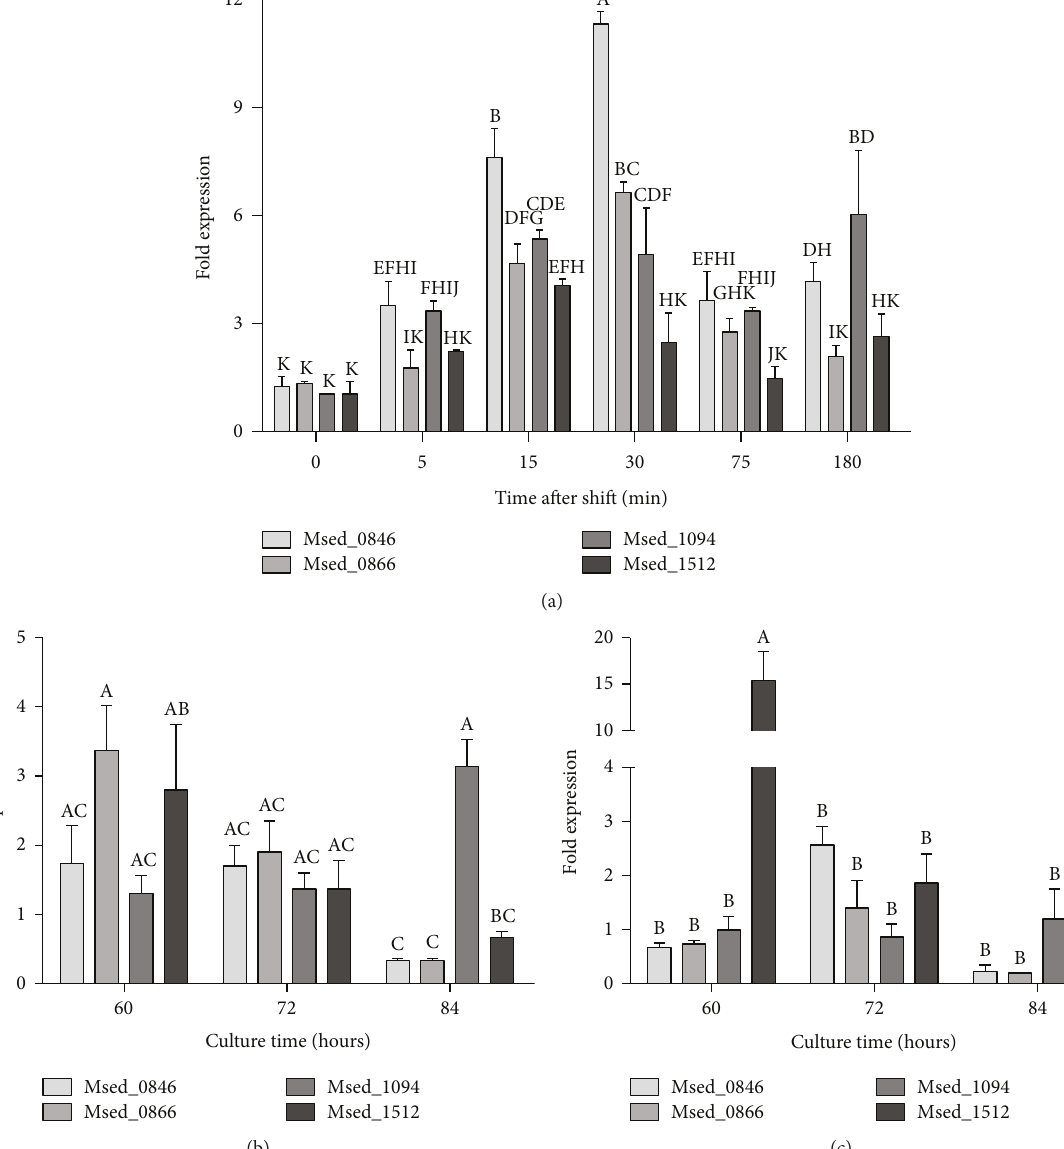
Figure 6: Di ff erential transcriptional expression of putative pho84 -like genes in M. sedula DSM 5348 T cells subjected to copper. (a) Nonadapted cells exposed to an 8 mM copper shift during the indicated times. (b) Nonadapted cells exposed to 8mM CuSO indicated culture times. (c) Adapted cells exposed to 16 mM CuSO